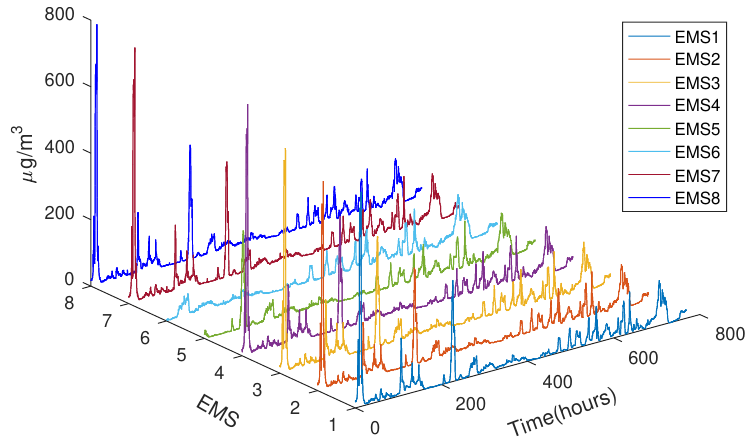
Figure 5. On-site PM2.5 concentration during 10 DEC 2019–10 JAN